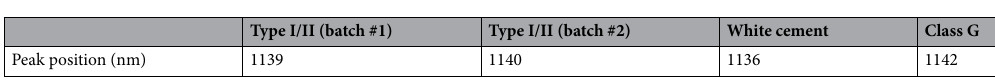
Figure 5. Emission spectra from three cement formulations, with 660 nm excitation. Left panel shows a wide spectral view; right panel shows the same data expanded near the peaks. All specimens were cured and fully hydrated.